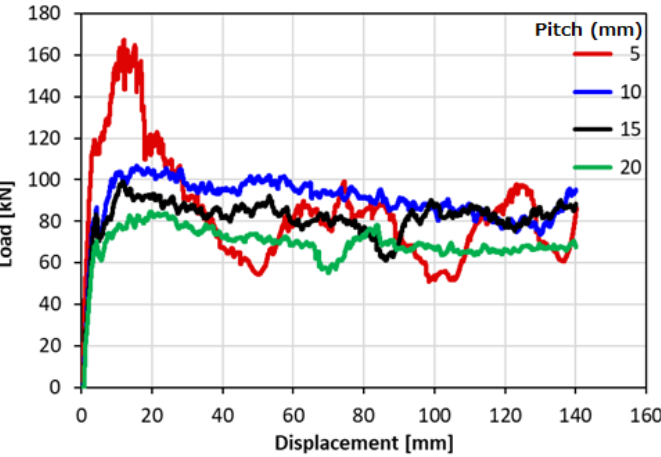
Figure 12. Load – displacement curves of 16 ply.